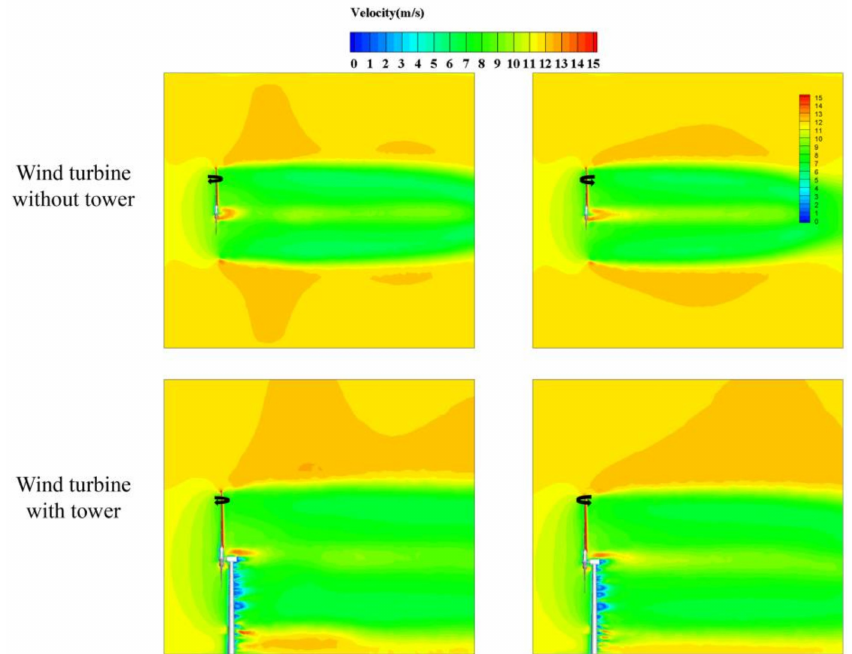
Figure 24. Velocity contours of wake field under yaw